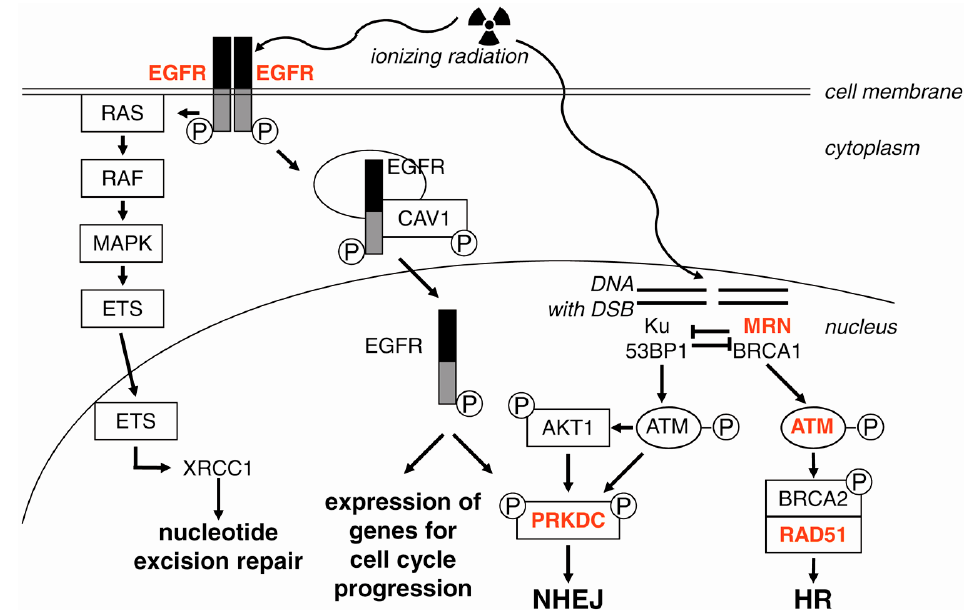
Figure 4. Induction of DNA repair by EGFR signaling. Irradiation (symbolized by the sinuous arrows and the trefoil) results in ligand-independent dimerization of EGFR and autophosphorylation at the cytoplasmic domains, resulting, on the one hand, in activation of the classical RAS/RAF/MAPK pathway, which causes the expression of XRCC1 (X-ray repair cross-complementing group 1) and, thereby, the activation of the nucleotide excision repair. On the other hand, EGFR is internalized in complex with CAV1 and then released into the nucleus, where it functions as a transcription factor for genes required during G1/S progression and activates PRKDC (DNA-PKcs), which plays a pivotal role during NHEJ. AKT1 was also shown as an activator of PRKDC. During the G1 phase, Ku and 53BP1 bind to the DSB (double strand break as symbolized by a gab in the DNA) band activate ATM, which possesses a PI3K domain enabling phosphorylation and activation of AKT1. During the S and G2 phase, the MRN complex and BRCA1 inhibit Ku and 53BP1 and induce DNA repair by homologous recombination (HR). Arrows symbolize activation or translocation to the nucleus (described in the text); bar-headed lines symbolize inhibition. Targets for radiosensitization are in red. See text for details. ERBB receptors are also potent stimulators of the RAS/RAF/MAPK pathway. Constant